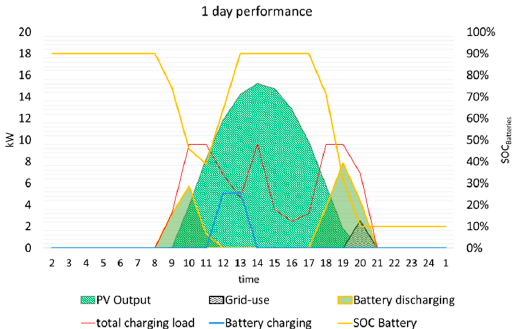
Figure 15. One-day energy performance of the charging station when driven distance is increased to 80 km/day.